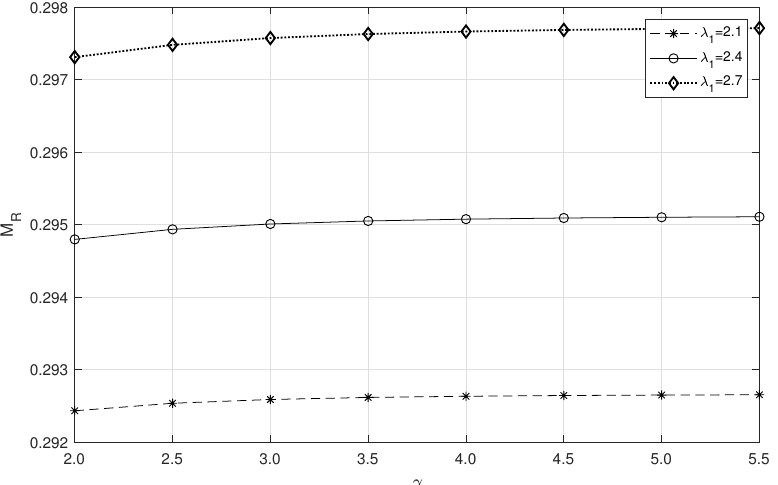
Figure 5. Mean reorder rate on λ 1 vs. γ .